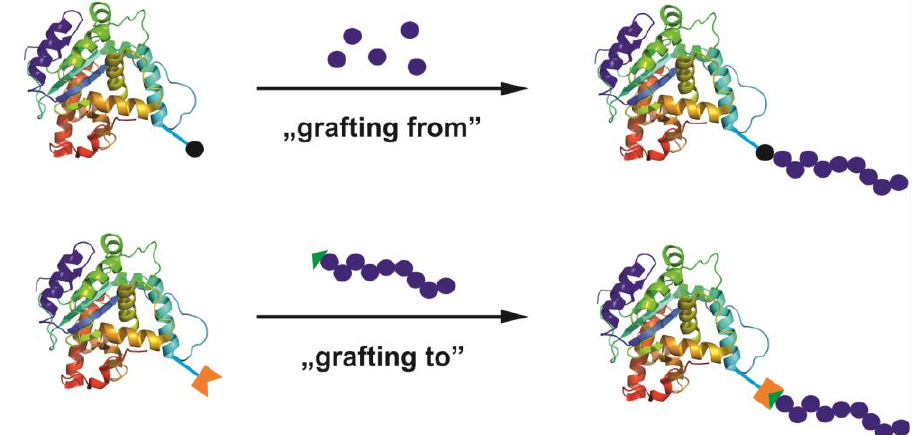
Figure 13. Two main strategies for obtaining polymer – protein conjugates.